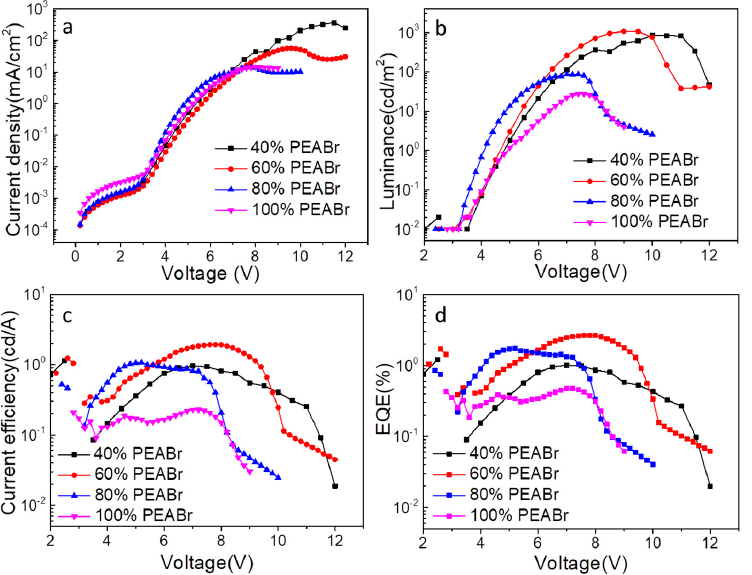
Figure 5. Performance of CsPbCl 0.75 Br 2.25 PeLEDs with different ratios of PEABr. ( a ) current density versus voltage, ( b ) luminance versus voltage, ( c ) current efficiency versus voltage, and ( d ) EQE versus voltage curves. Table 2. Summary of CsPbCl 0.75 Br 2.25 PeLEDs with different ratios of PEABr.